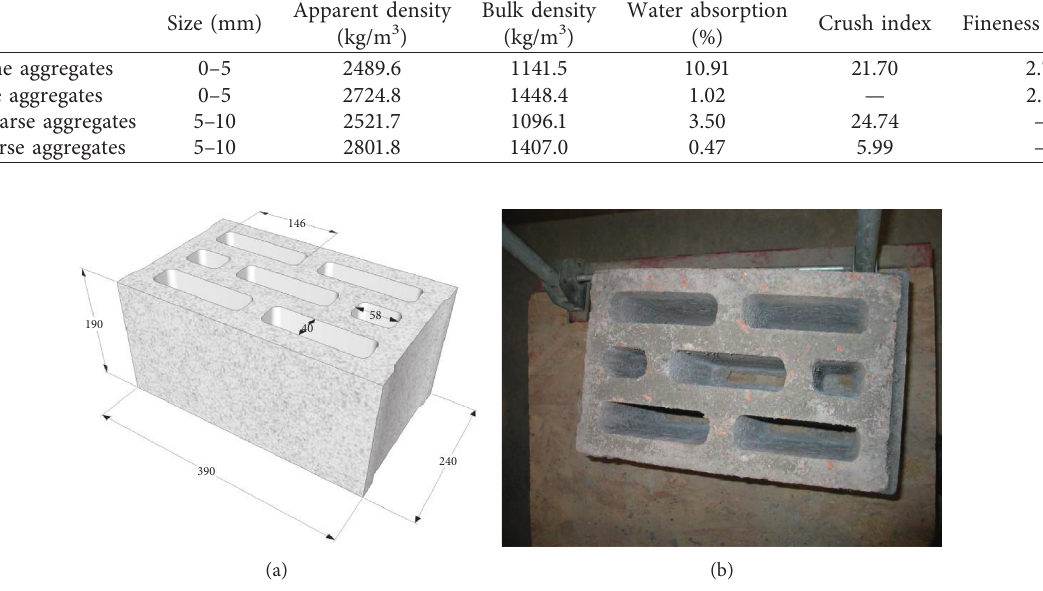
Figure 2: RCB containing three rows of holes. (a) Dimensions (mm); (b) actual diagram.